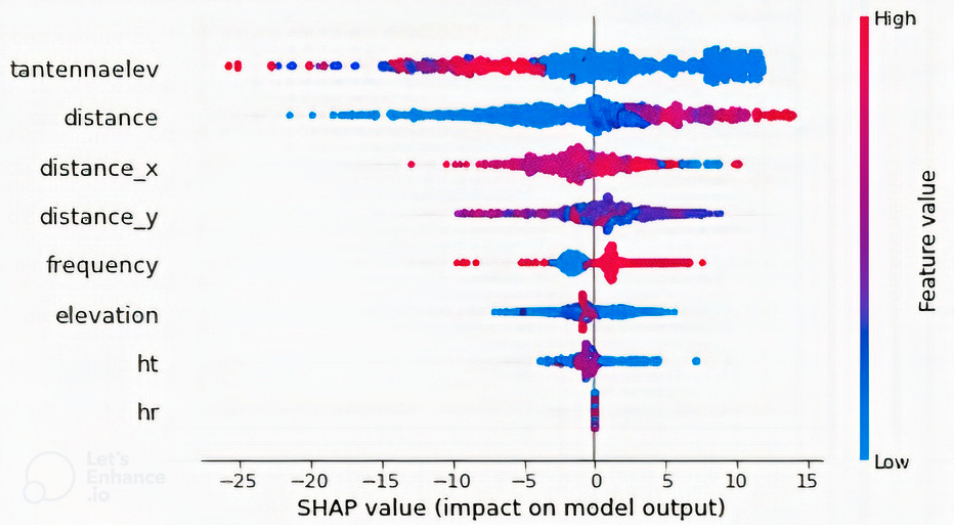
Figure 6. SHAP summary plot of the model with non-image features only, showing the variations in feature values with output path loss value.